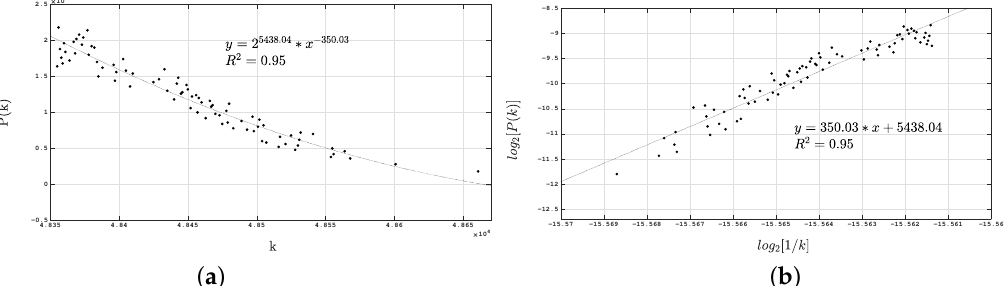
Figure 8. ( a ) P ( k ) vs. k plot and ( b ) log 2 [ P ( k )] vs. log 2 ( 1/ k ) plot generated from the 3D Visibility Graph for the data space [ x , y , z ] ss . R 2 is a statistical measure of fit that indicates how much variation of a dependent variable is explained by the independent variable(s) in a regression